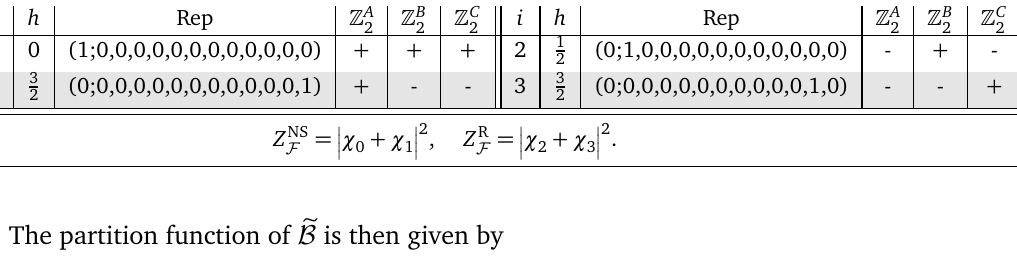
( τ ) . Primaries i = 1,2,3 are the generator of (cid:90) A i subgroup of the center symmetry (cid:90) 2